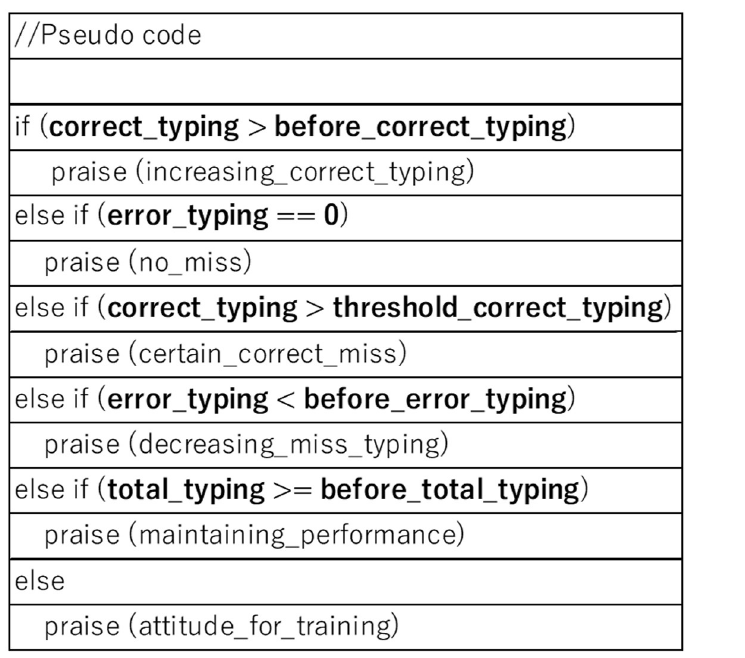
Fig 4. Pseudo-code for praise comment